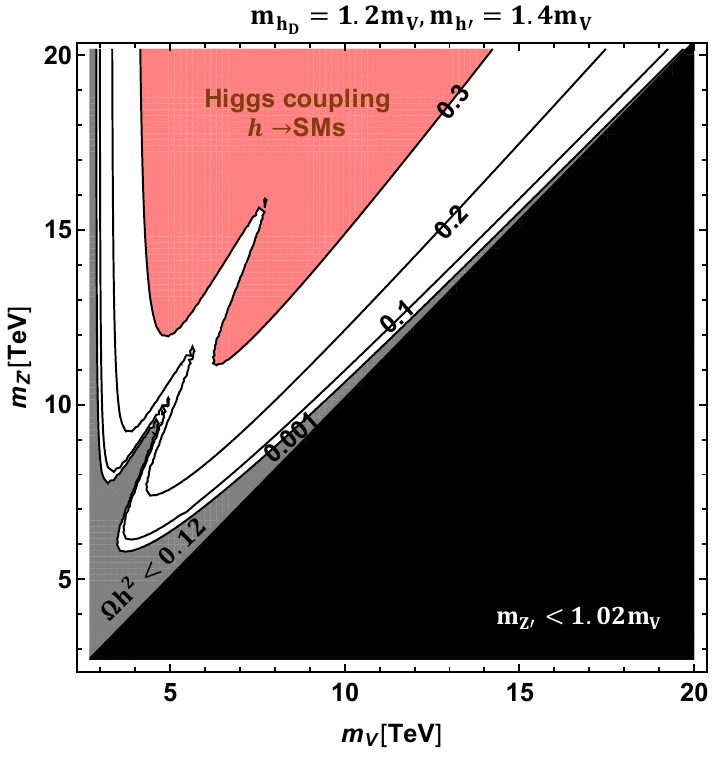
Figure 5 . The contours show (cid:30) h that reproduce the measured value of the DM relic abundance. Here, m h = 1 : 2 m V and m h 0 = 1 : 4 m V . In the gray shaded region, this model cannot explain D the whole abundance. The pink region ( (cid:30) h > 0 : 3) is constrained by the measurement of the Higgs signal strength [46]. In the black shaded region, g 0 is beyond the perturbative unitarity